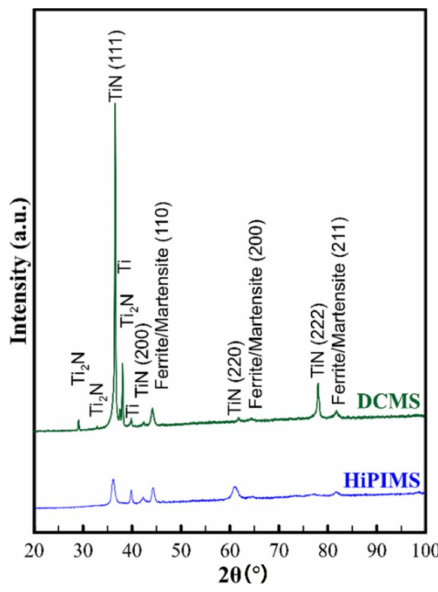
Figure 1. X-ray Di ff raction (XRD) spectra of TiN deposited on high speed steel (HSS) using HiPIMS and DCMS techniques.